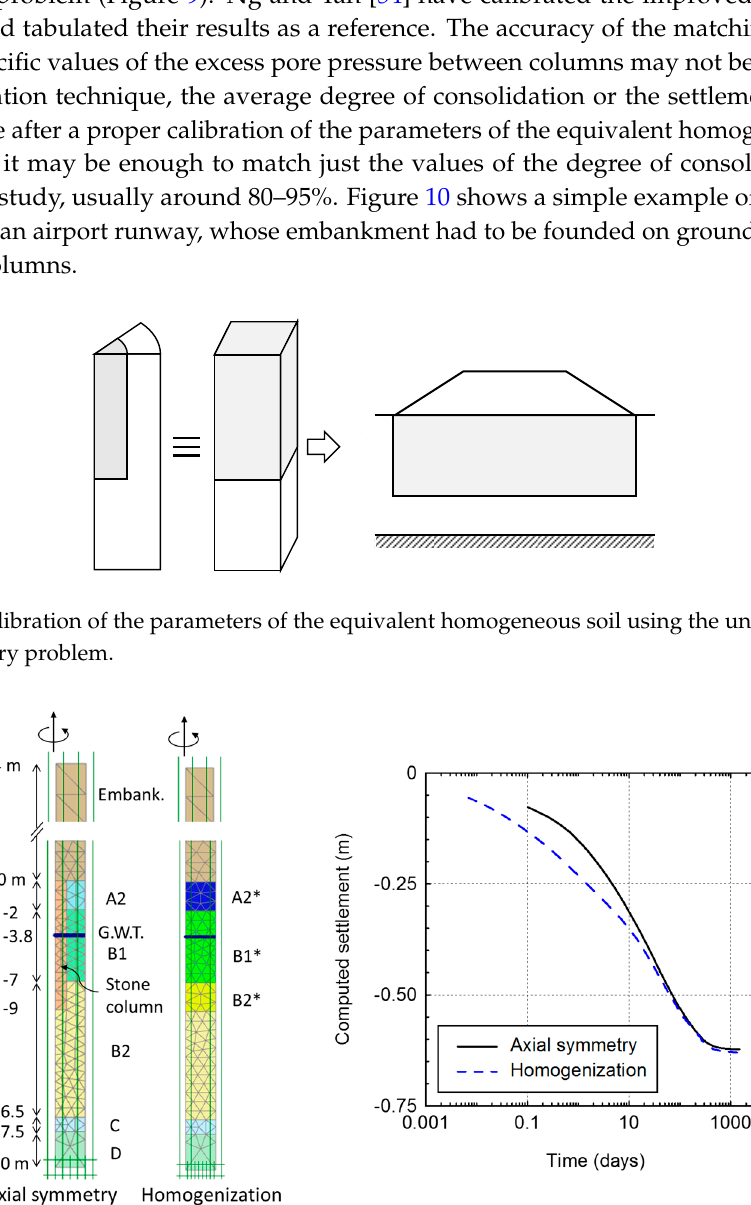
Figure 10. Example of calibration of the parameters of the equivalent homogeneous soil using the unit cell model as an auxiliary problem.